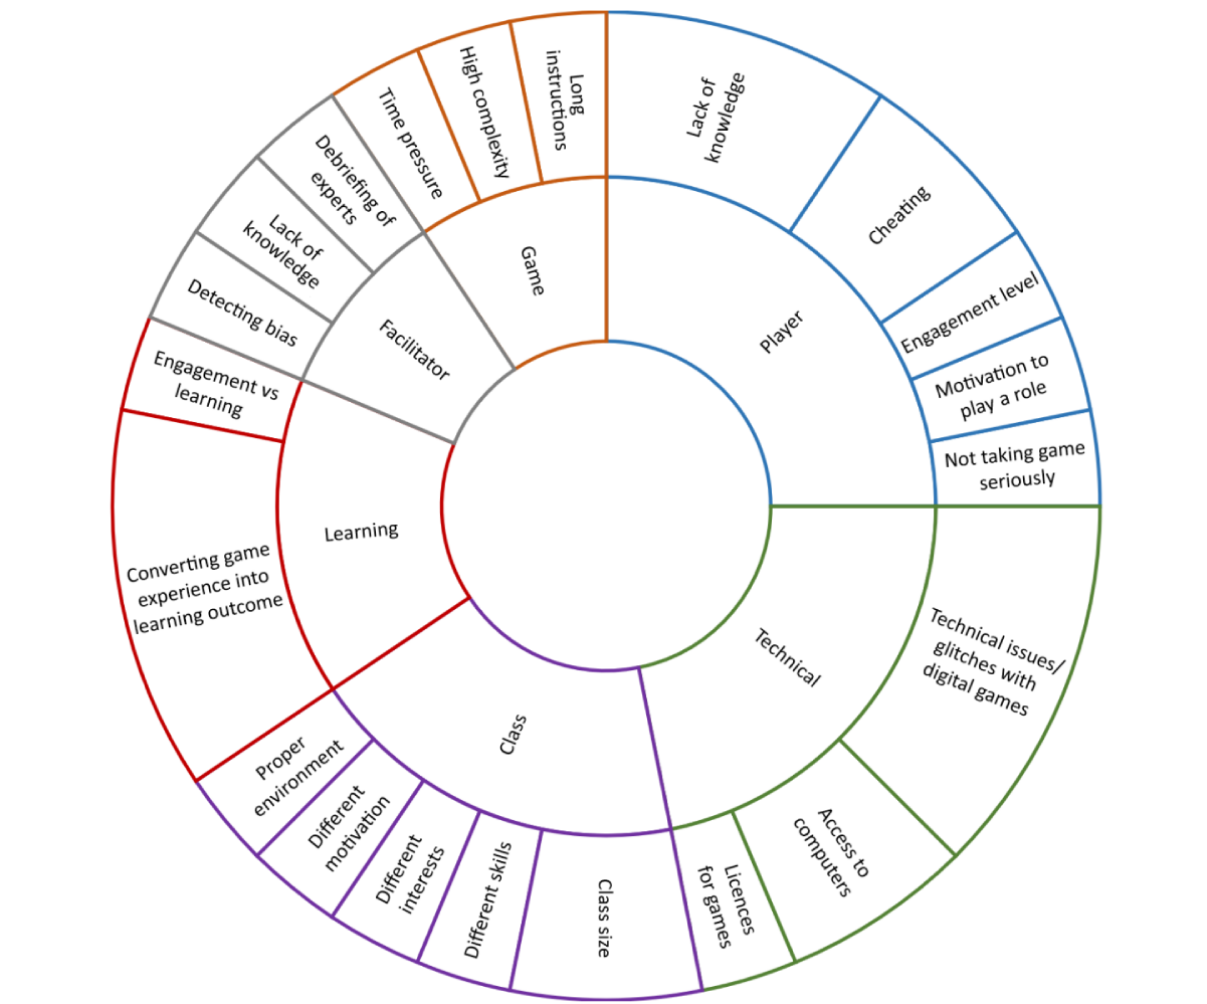
Figure 2. Cluster diagram of challenges in game facilitation as elicited by open-ended questions